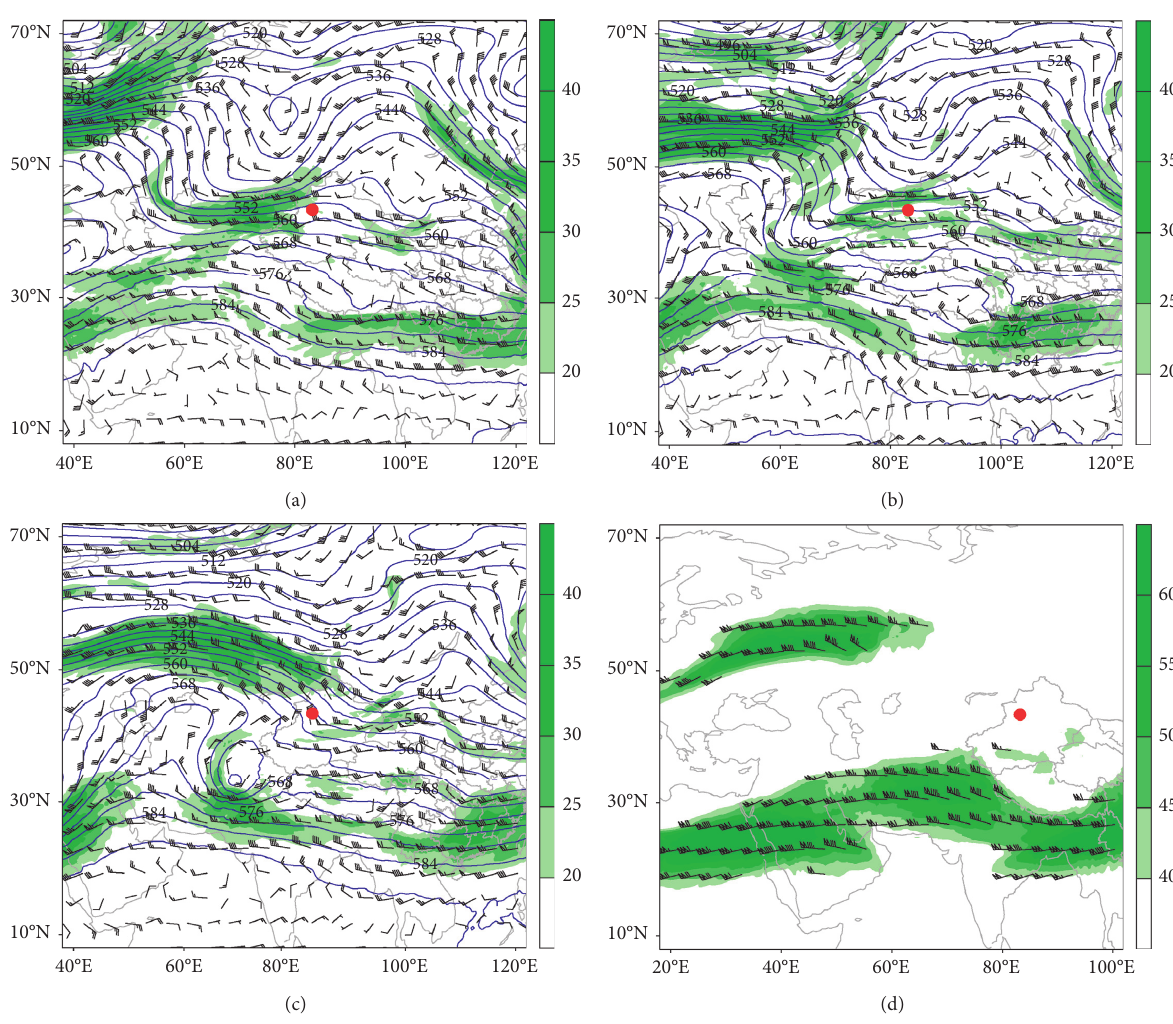
Figure 3: The geopotential height (blue solid line; unit, dagpm), wind field (wind pole; unit, ms − 1 ), jet stream (shadow; unit, ms − 1 ) at 500hPa (a) at 18:00 on February 17, (b) at 12:00 on February 18, (c) at 06:00 on February 19, 2020, and (d) high-altitude jet stream (shadow; unit, ms − 1 ) at 200hPa (the red spot represents the Xinyuan station).